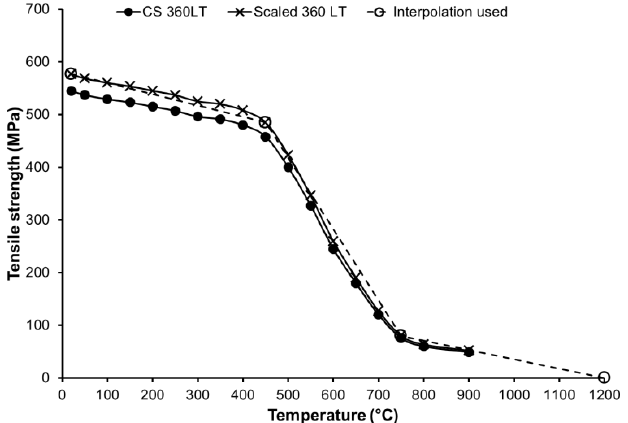
Figure 3. Assumed material tensile strength as a function of temperature. Data adapted from [9] and scaled to give the assumed UTS of 560 MPa at 100 °C.